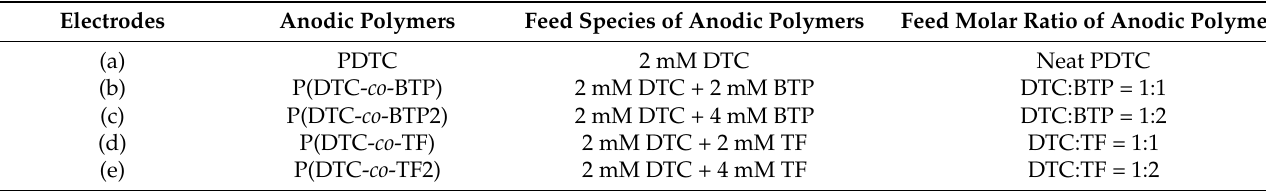
Table 1. Feed species of anodic polymers.